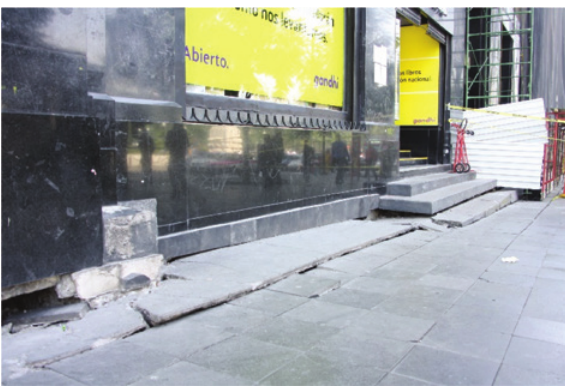
Figure 9: Evidence of soil-structure interaction in Mexico City (Photo courtesy of S. Brûlé and A.F.P.S. [69]).